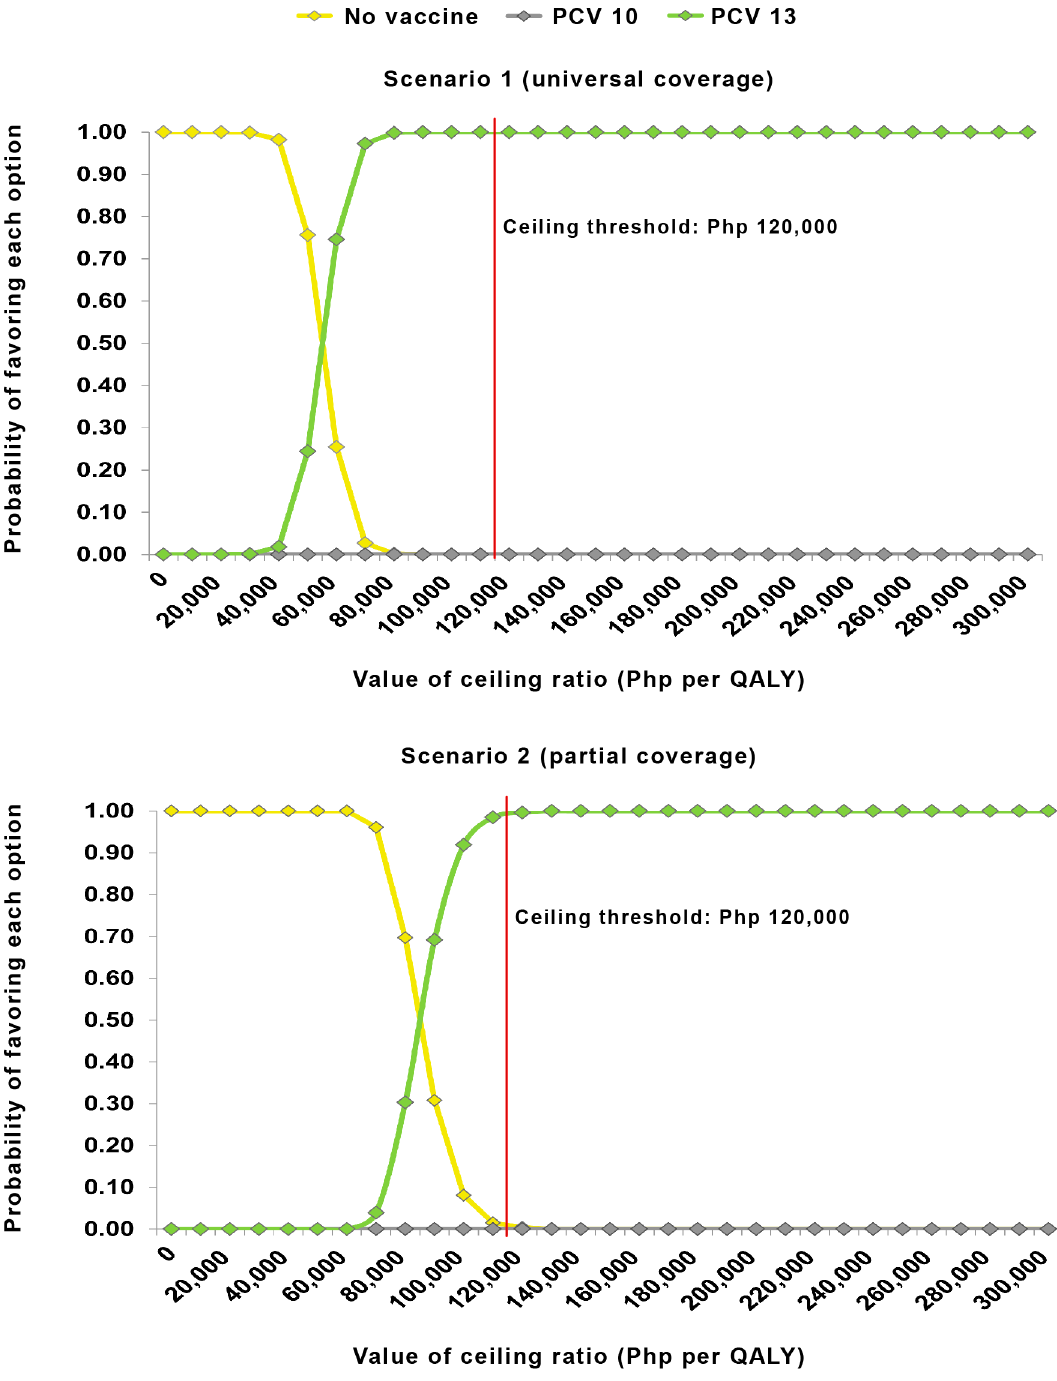
Fig 5. Cost-effectiveness acceptability curves for PCV10, PCV13 and no vaccination in the scenarios of universal and partial coverage.